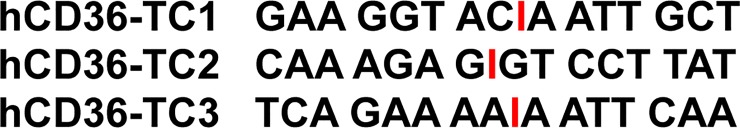
CD36 target sites for insertion of the tetracysteine motif.Part of CD36 coding sequence showing the exact positions where the tetracysteine tag was introduced for each of the mutant.